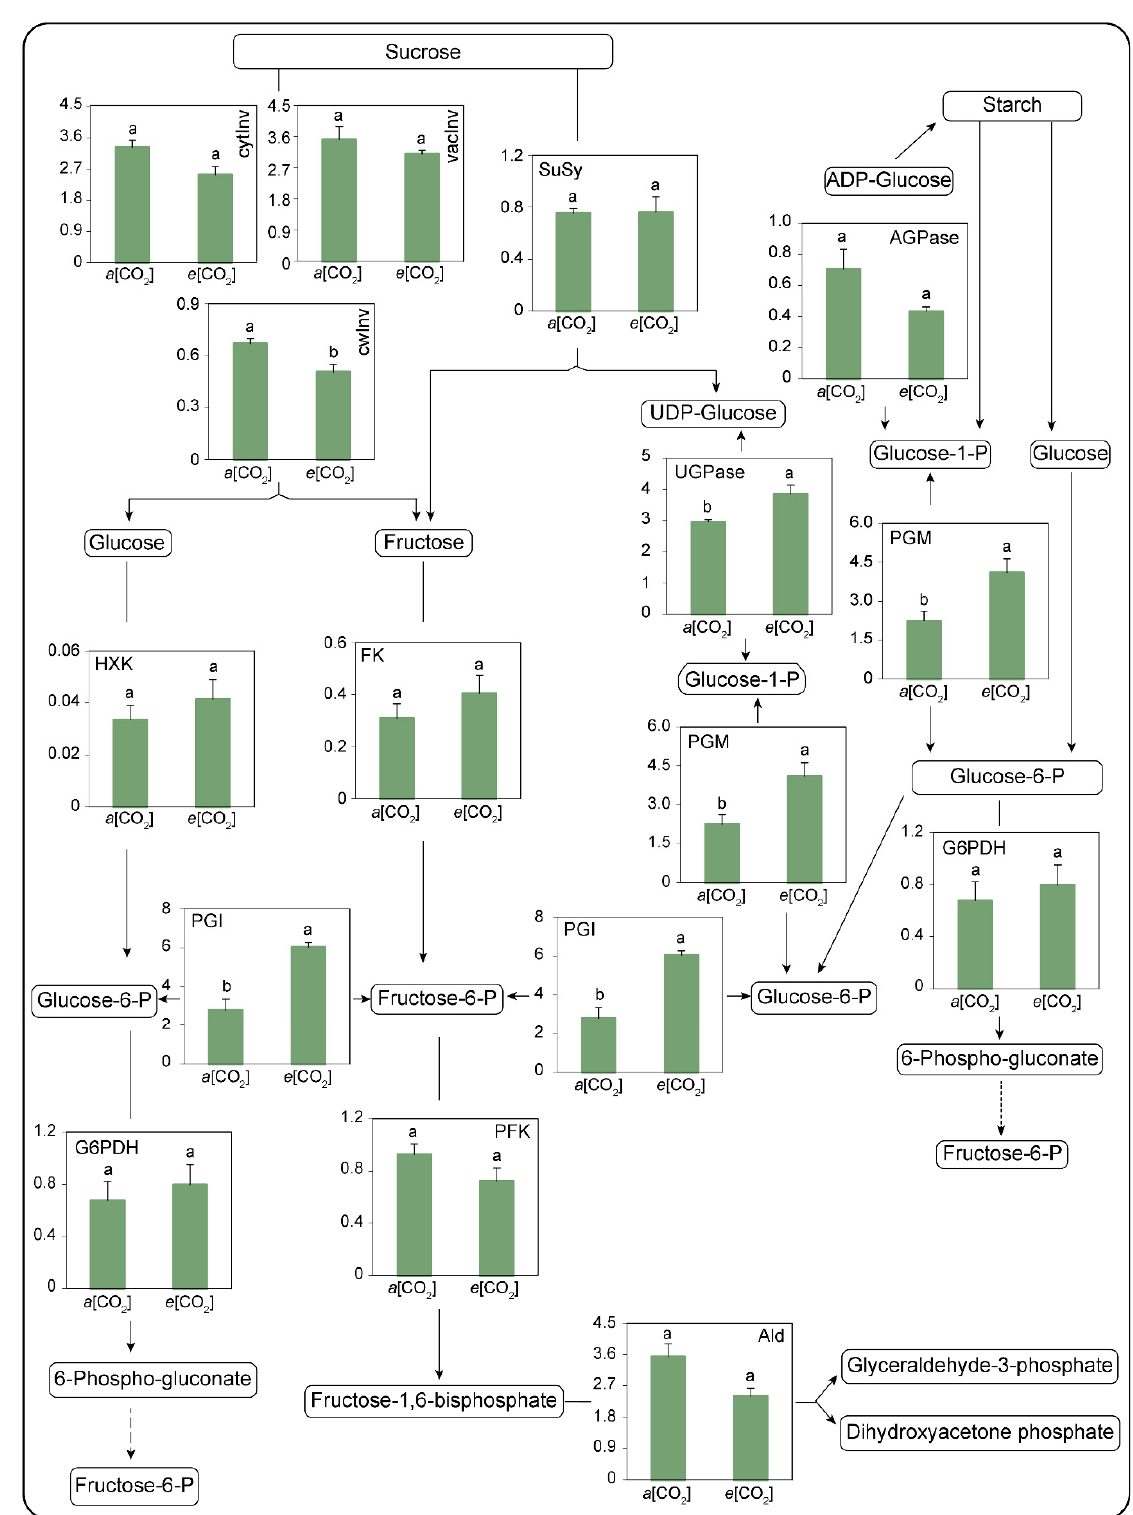
Figure 4. Specific activities of key carbohydrate metabolism enzyme in leaves of Phragmites australis grown under ambient ( a [CO 2 ], 400 ppm) and elevated ( e [CO 2 ], 800 ppm) atmospheric CO 2 concentrations. Different small letters mean significant difference at p < 0.05 level. Data are expressed as means ± SEM (n = 3). AGPase, ADP-glucose pyrophorylase; Ald, aldolase; cytInv, cytoplasmic invertase; cwInv, cell wall invertase; FK, fructokinase; Fructose-6-P, fructose-6-phosphate; Glucose-1- P, glucose-1-phosphate; Glucose-6-P, glucose-6-phosphate; G6PDH, glucose-6-phosphate dehydrogenase; HXK,